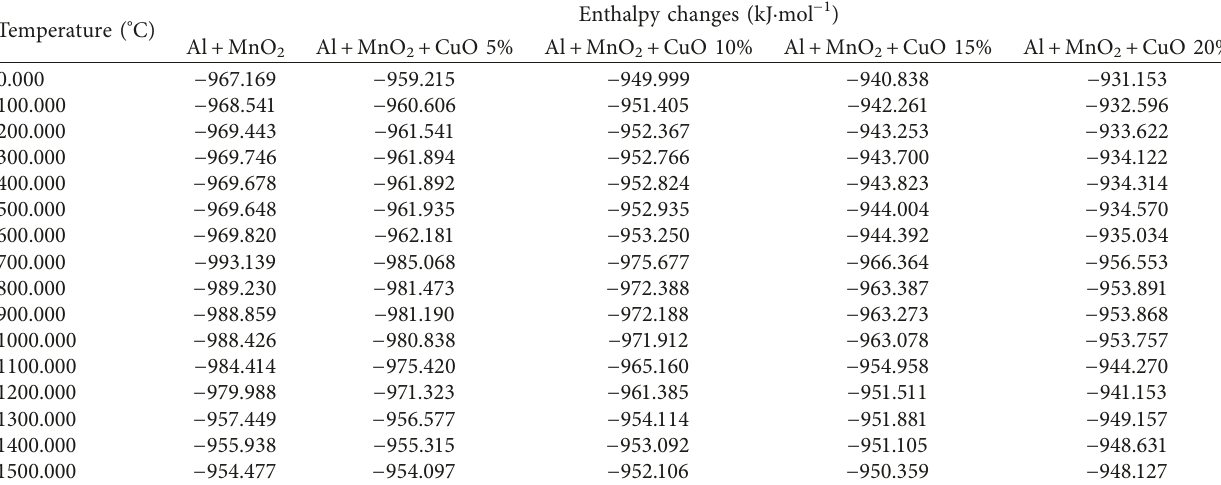
Table 3: Enthalpy changes of five